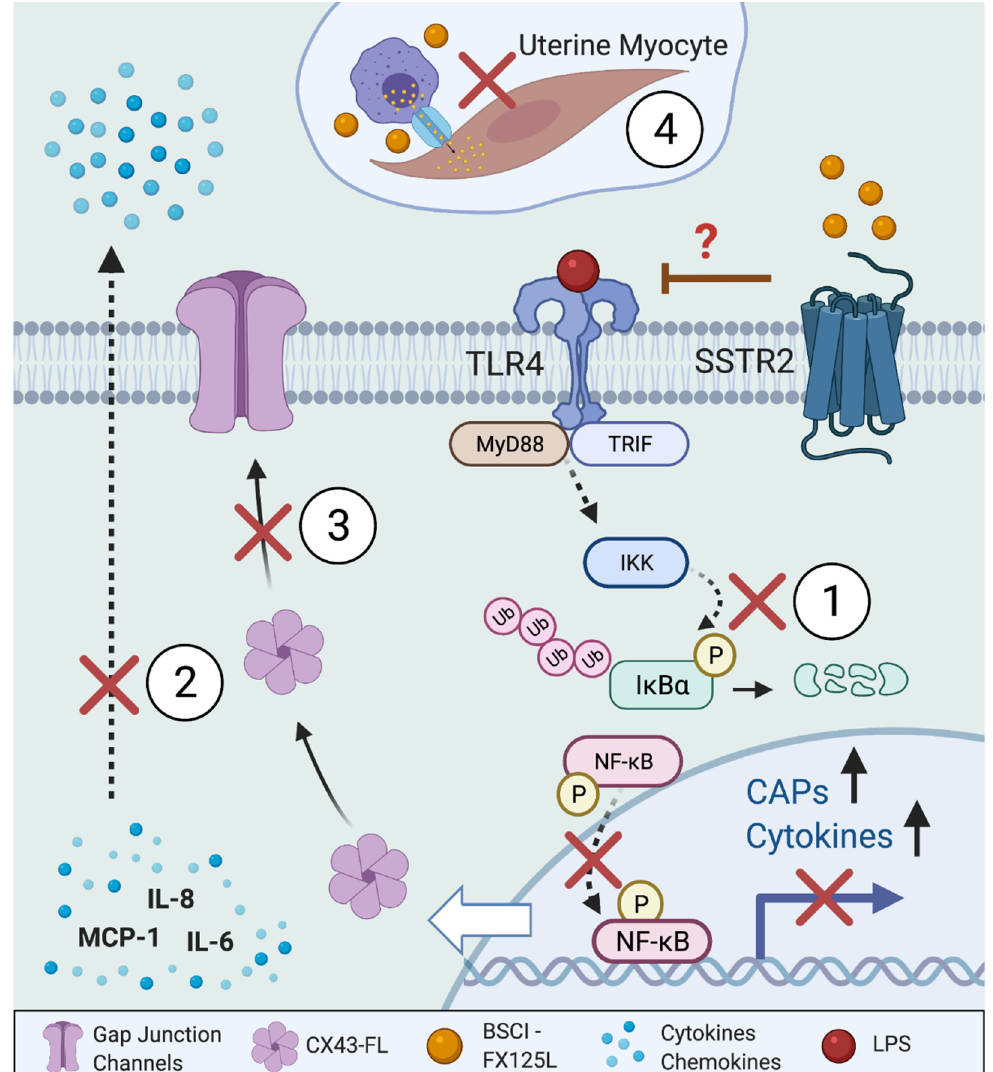
Figure 9. Putative model of BSCI’s action on myometrium. (1) BSCI (likely acting through SSTR2) inhibits TLR4-induced NF- κ B intracellular signaling by blocking phosphorylation of the inhibitory protein I κ B α , which prevents phosphorylation of p65 protein and its translocation into the nucleus, (2) thus decreasing the expression and secretion of myometrial chemokines, (3) CX43 trafficking to the membrane is decreased by BSCI, which inhibits intercellular GJ communication, (4) myocyte– macrophage interaction, and myometrial contractility.